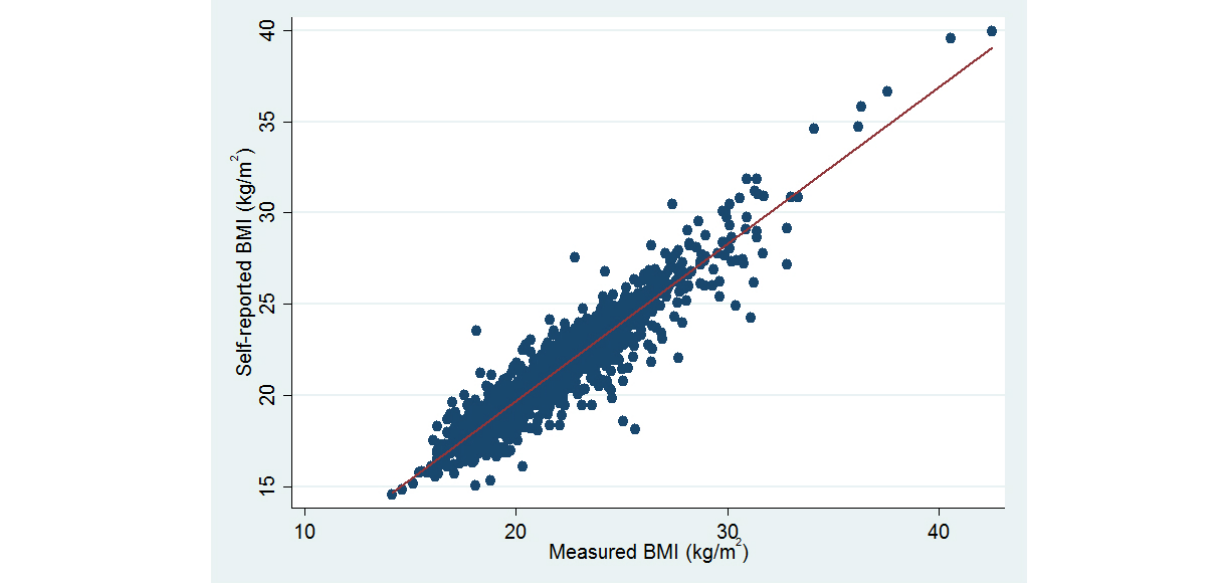
Figure 2. Scatterplot of self-reported (y-axis) and measured (x-axis) BMI (kg/m2), r=.94, P <.001